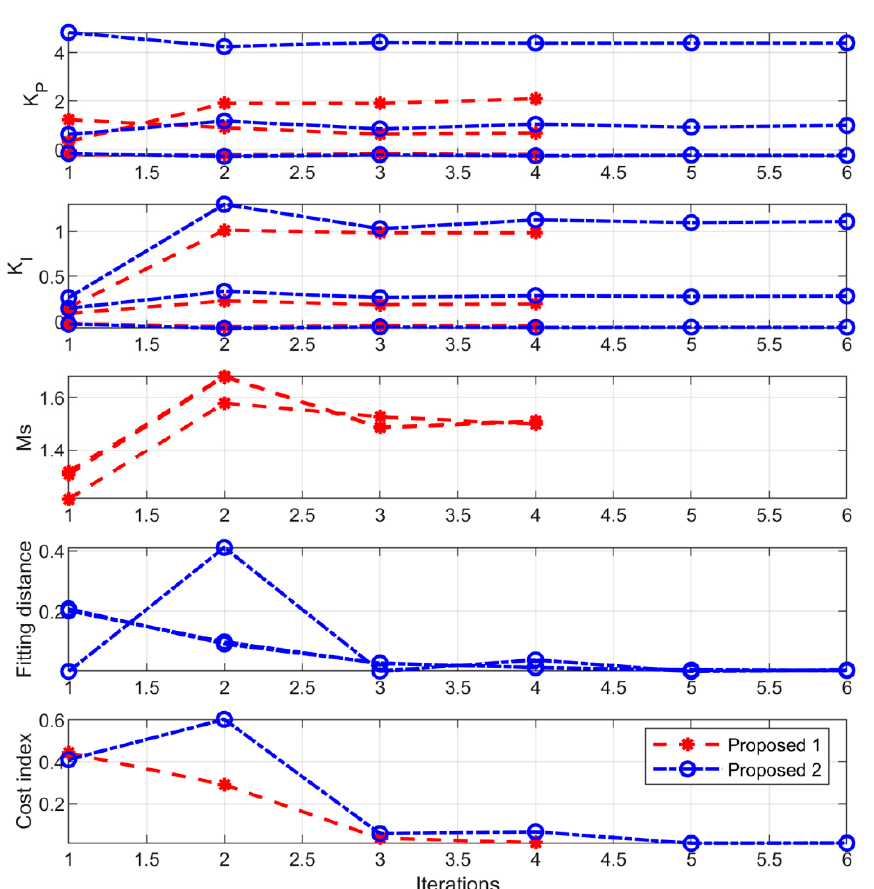
Figure 12. Evolution of PI parameters, required specifications and cost index through the proposed iterative procedure in example 2. Table 2. Proposed multiloop PID controllers and their corresponding robustness and performance indices in example 2. Specifications in Each